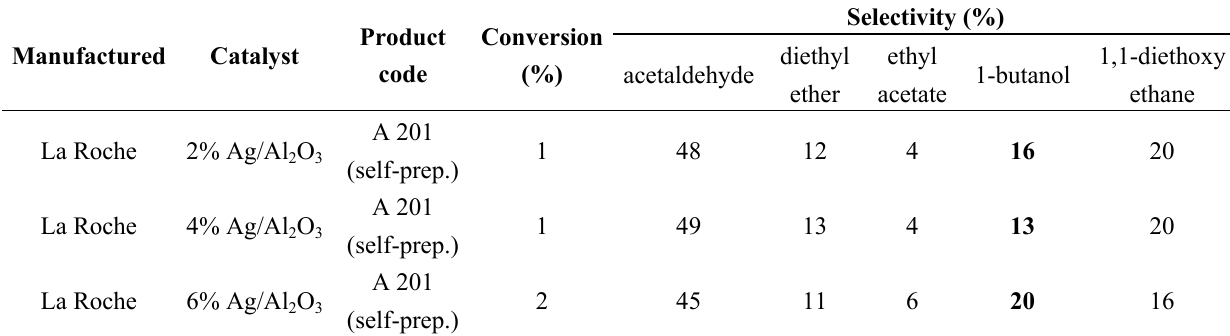
O catalyst. XRD 2 3